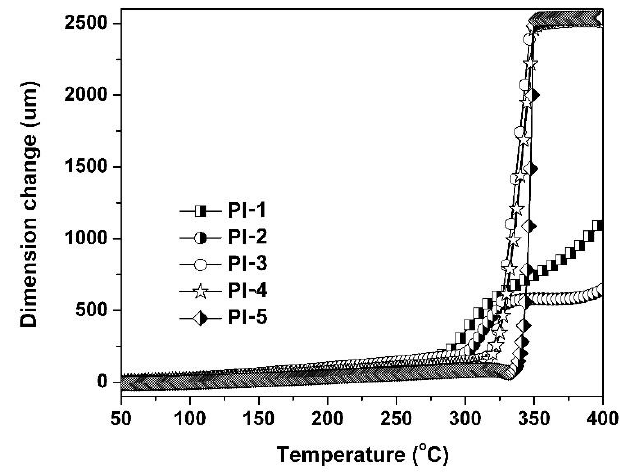
Figure 8. TMA plots of PI coatings.